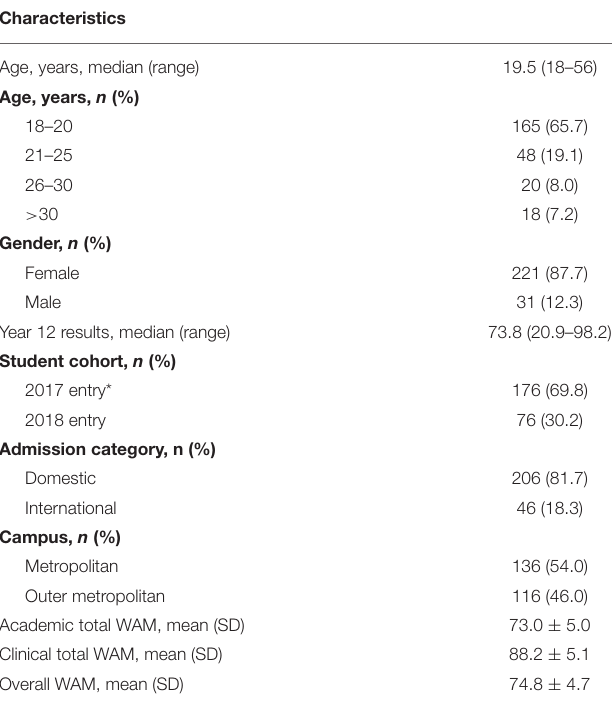
TABLE 1 | Participant’s characteristics.